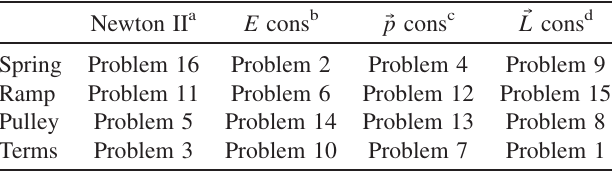
TABLE I. Veldhuis’s matrix method. Deep structures are listed along the top. Surface features are listed along the left. By ‘‘terms’’ Veldhuis includes ‘‘physical arrangements of objects and literal physics terms’’ in the problem text [9]. Veldhuis created this set hoping that experts would group the problems by column and novices would group the problems by